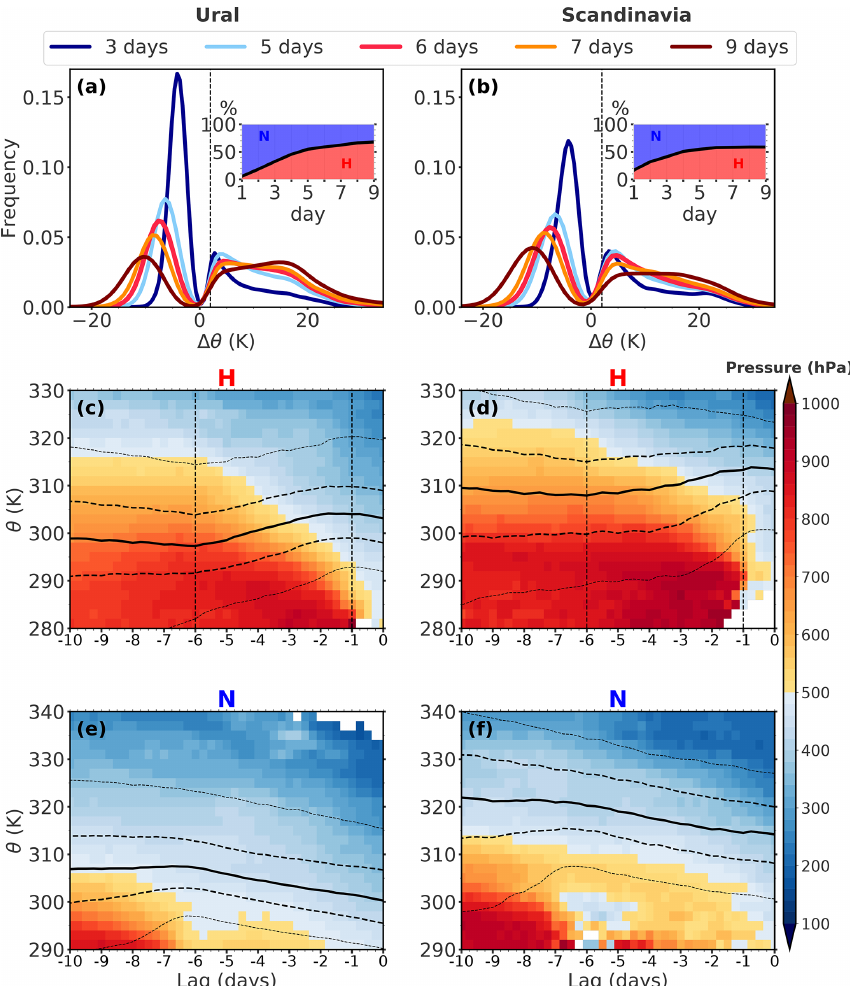
Figure 7. Ural (first column) and Scandinavian (second column) blocking trajectory regimes and their characteristics. (a, b) Frequency distribution of maximum change in potential temperature along back trajectories initialized from Ural (a) and Scandinavian (b) blocks during 3 (blue), 5 (light blue), 6 (pink), 7 (orange) and 9 (brown) days before their arrival into the blocking region. The threshold value of (cid:49)θ = 2K is shown by the black vertical dashed line. The inset figure shows the percentages of trajectories counted in the no-heating (N, blue) and heating (H, red) regimes by increasing the length of trajectories. Figure is inspired by Steinfeld and Pfahl (2019). (c–f) Pressure evolution (hPa, shading) with potential temperature on the vertical axis of blocking trajectories within the two regimes: heating (H, in red) (c, d) and no-heating (N, in blue) (e, f) , averaged within each grid box (6h × 2K). Note the different y -axis range for the two regimes. The distribution of trajectories is shown in black lines (median in solid, thick dashed lines for the interquartile range (IQR) and the thin dashed lines for the 5th–95th percentile range). The regime separation in panels (c) – (f) is based on 6d back trajectories. The two vertical black dashed lines in panels (c) and (d) mark the lifting window between lags − 1 and −